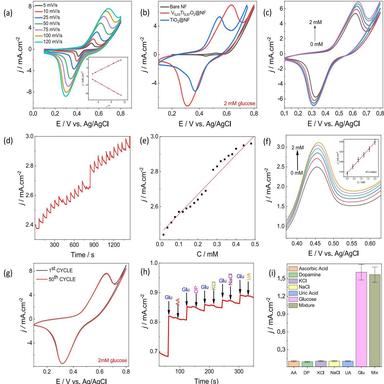
(a) Cyclic voltammogram of V0.03Ti0.97O2@NF in 0.1 M KOH at increasing scan rates from 5-120 mV/s. The corresponding anodic peak current and cathodic peak current as a function of the square root of the scan rate (Inset); (b) Cyclic voltammogram of V0.03Ti0.97O2 @NF, TiO2@NF, and bare NF in 0.1 M KOH with the presence of 2 mM glucose; (c) The successive addition of glucose in 0.1 M KOH at the scan rate of 50 mV/s; (d) The CA study of V0.03Ti0.97O2@NF in 0.1 M KOH with the successive addition of glucose in s